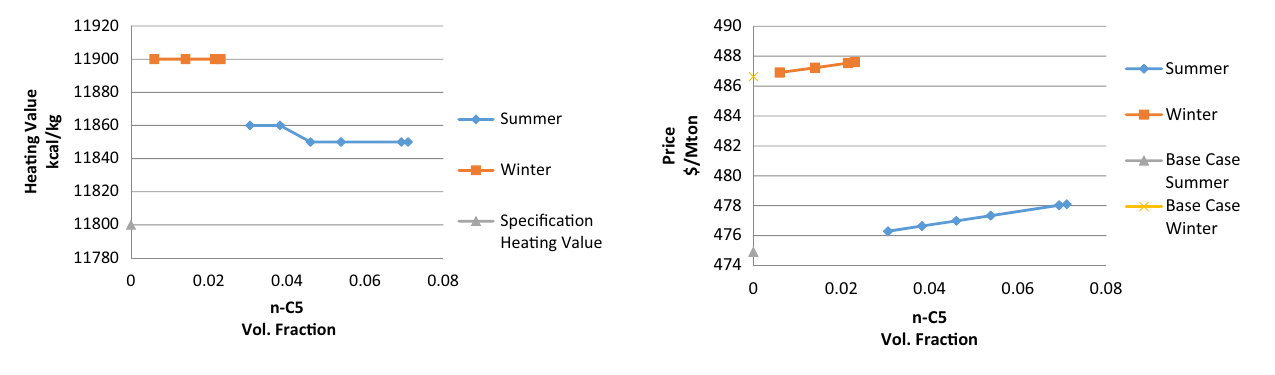
Fig. 21 Effect of adding n-C5 on LPG heating value